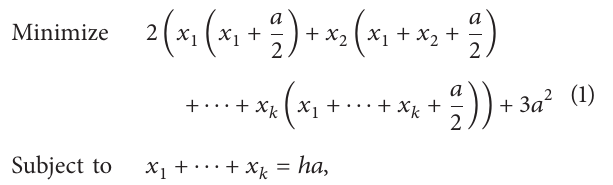
Algorithm DP1. (a) Number the orders in the predetermined sequence and (b) function